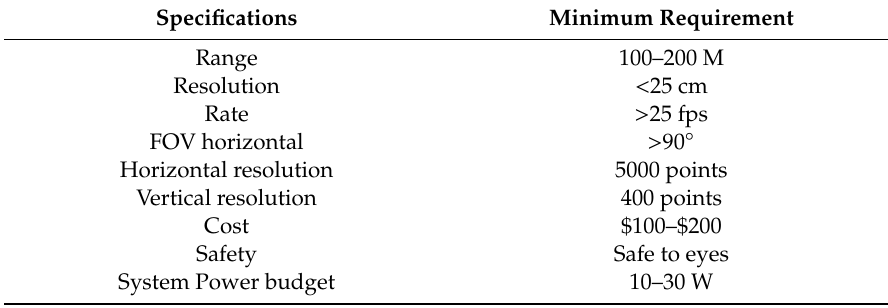
Table 6. Summary of LiDAR requirements for advanced driving assistance systems (ADAS) application